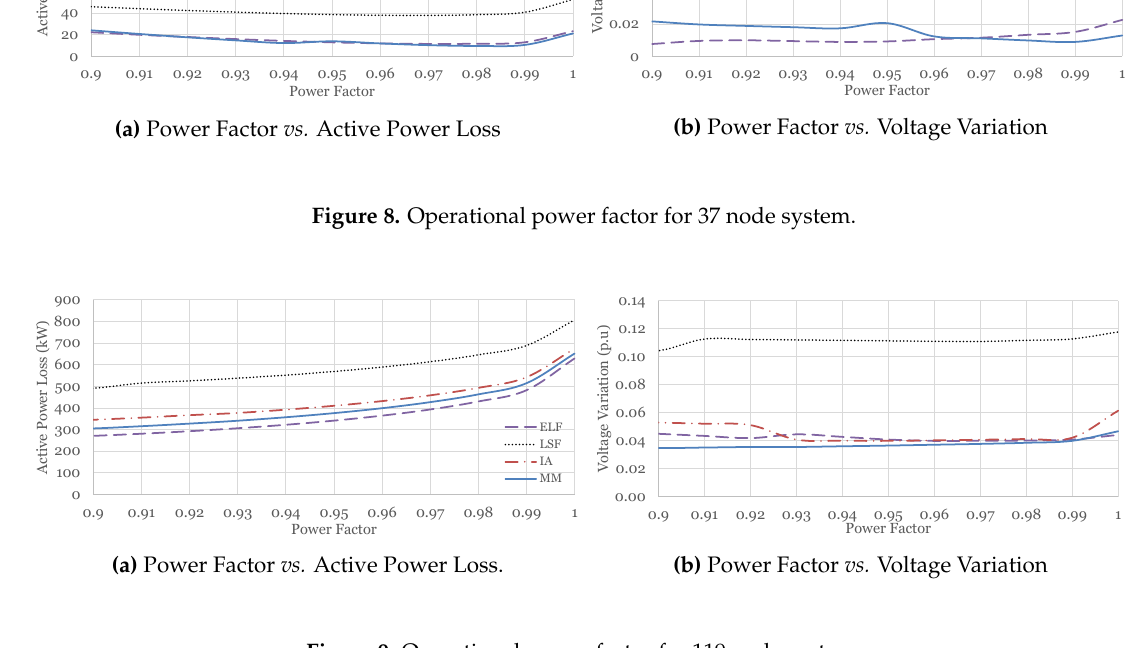
Figure 9. Operational power factor for 119 node